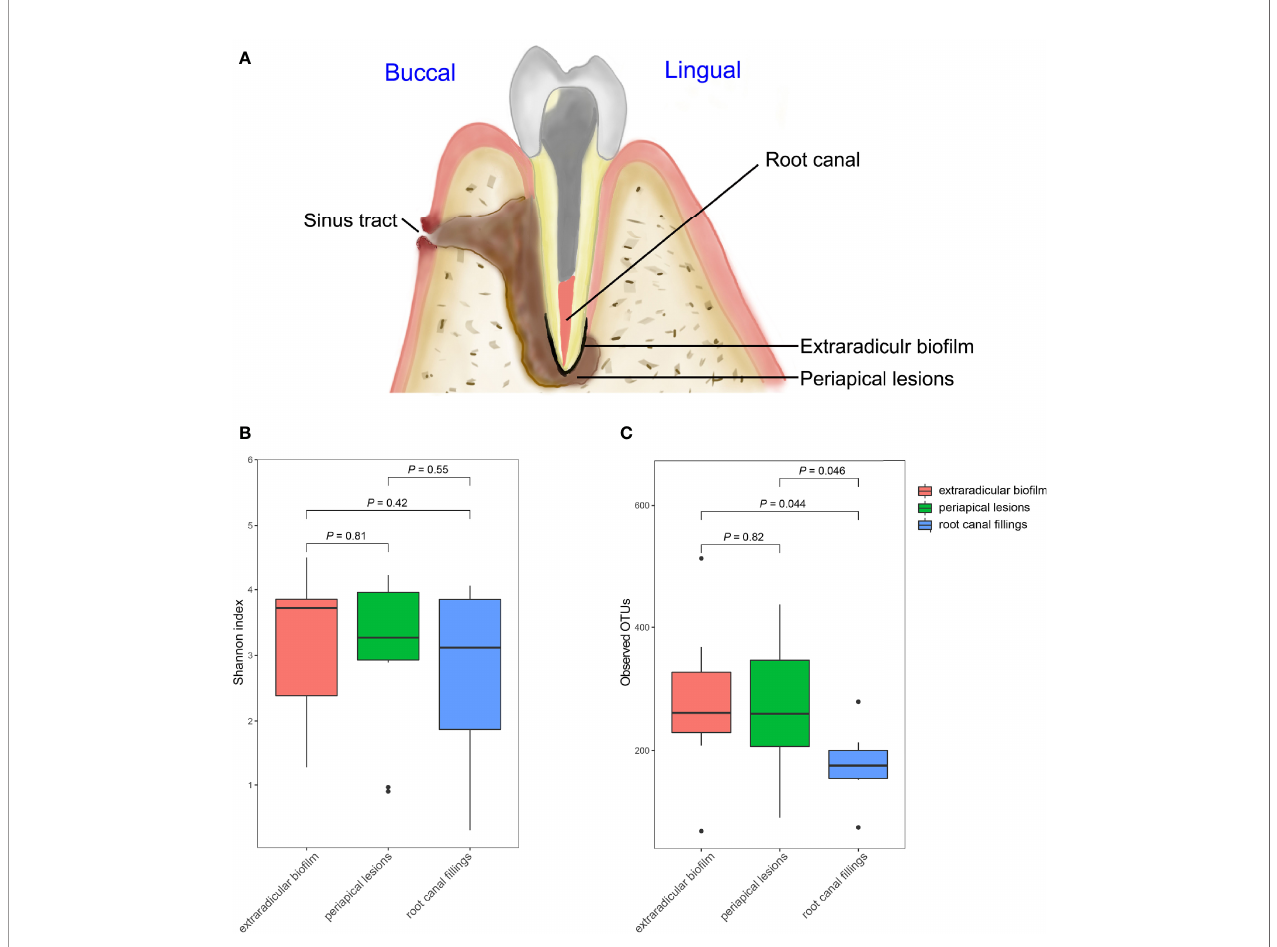
FIGURE 1 | Comparisons of Alpha diversities of samples collected from the root canal, extraradicular bio fi lm, and periapical lesions. (A) schematic diagram of sampling; (B) comparison of Shannon index; (C) Comparison of observed OTUs. The P -values were calculated using the student ’ s